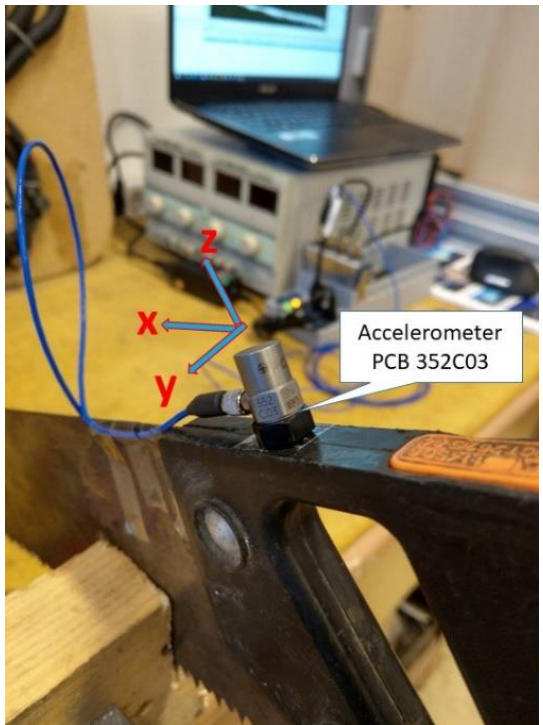
Figure 6. The equipment used for the vibration measurement: the accelerometer mounted on the hand saw.